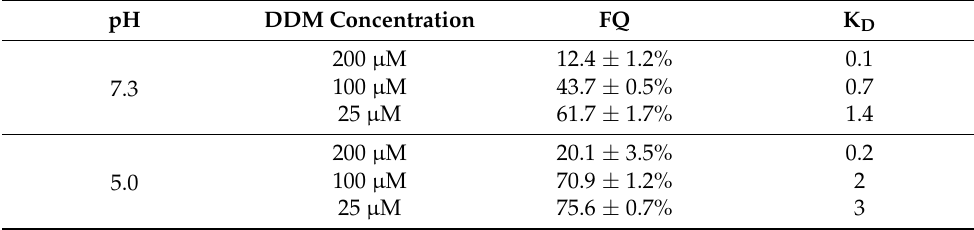
Figure 1. Fluorescence quenching analysis of LHCII trimers during bulk measurement in vitro. Panels ( A , B ) represent time course of fluorescence quenching of LHCII trimers (in HEPES 10 mM (pH 7.3) and 200 µM n-dodecyl- β -D-maltoside (DDM)) injected in a buffer of pH 7.3 ( A ) or 5.0 ( B ) at different detergent concentrations. ( C ) Titration curves of quenched fraction of fluorescence calculated from panels ( A , B ) (see the Section 4 for calculation). ( D ) Rate constants of fluorescence quenching, calculated by fitting time courses of fluorescence ( A , B ) with a sigmoidal Hill equation y = [axb]/[cb + xb] (see, for instance, [10,14] ). Circles/squares = data average; dashed lines = data fittings; error bars: SD. Data are average of three measurements. The proposed organization of the detergent around the LHCII single trimer above and below critical micellar concentration (CMC) is represented under the graphs. Table 1. Summary of the measured fluorescence fraction quenched (FQ) and calculated K D s in the samples measured in Figure 1.